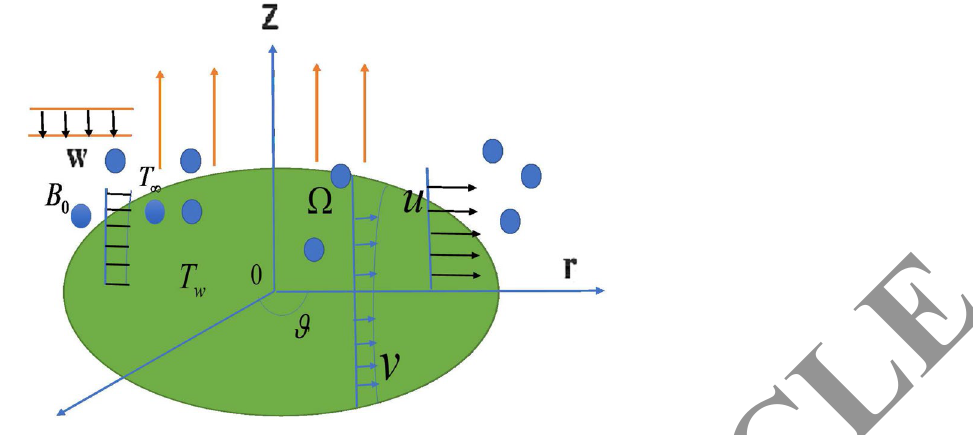
Figure 1. Physical model of the